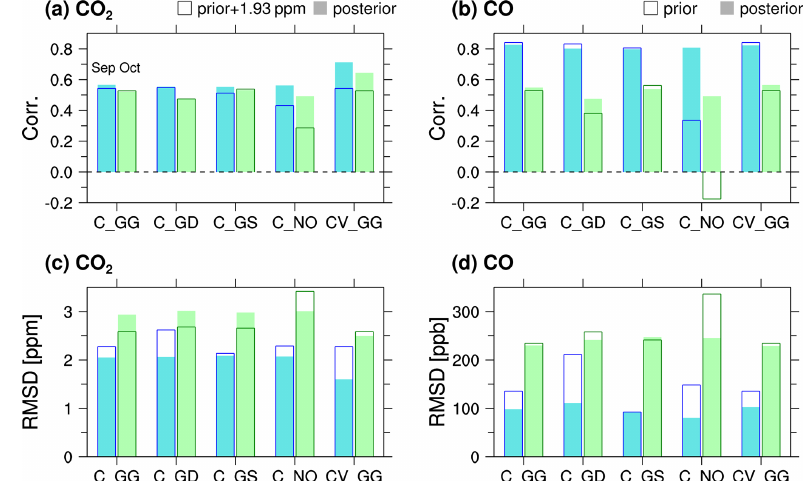
Figure 12. Correlation coefficient (a, b) and root mean square difference (RMSD) (c, d) between the observed and simulated NIES VOS CO 2 (a, c) and CO (b, d) mole fractions. The NIES VOS data used here are limited within the range of 95–125 ◦ E and 10 ◦ S–15 ◦ N for September (light blue) and October (light green) 2015. The model simulations are derived from each posterior flux (C_GG, C_GD, C_GS, C_NO and CV_GG) (filled bar) and its corresponding prior flux (open bar). To consider the initial global offset error, we added 1.93ppm to every prior value so that the prior initial global offset becomes equivalent to the posterior one.